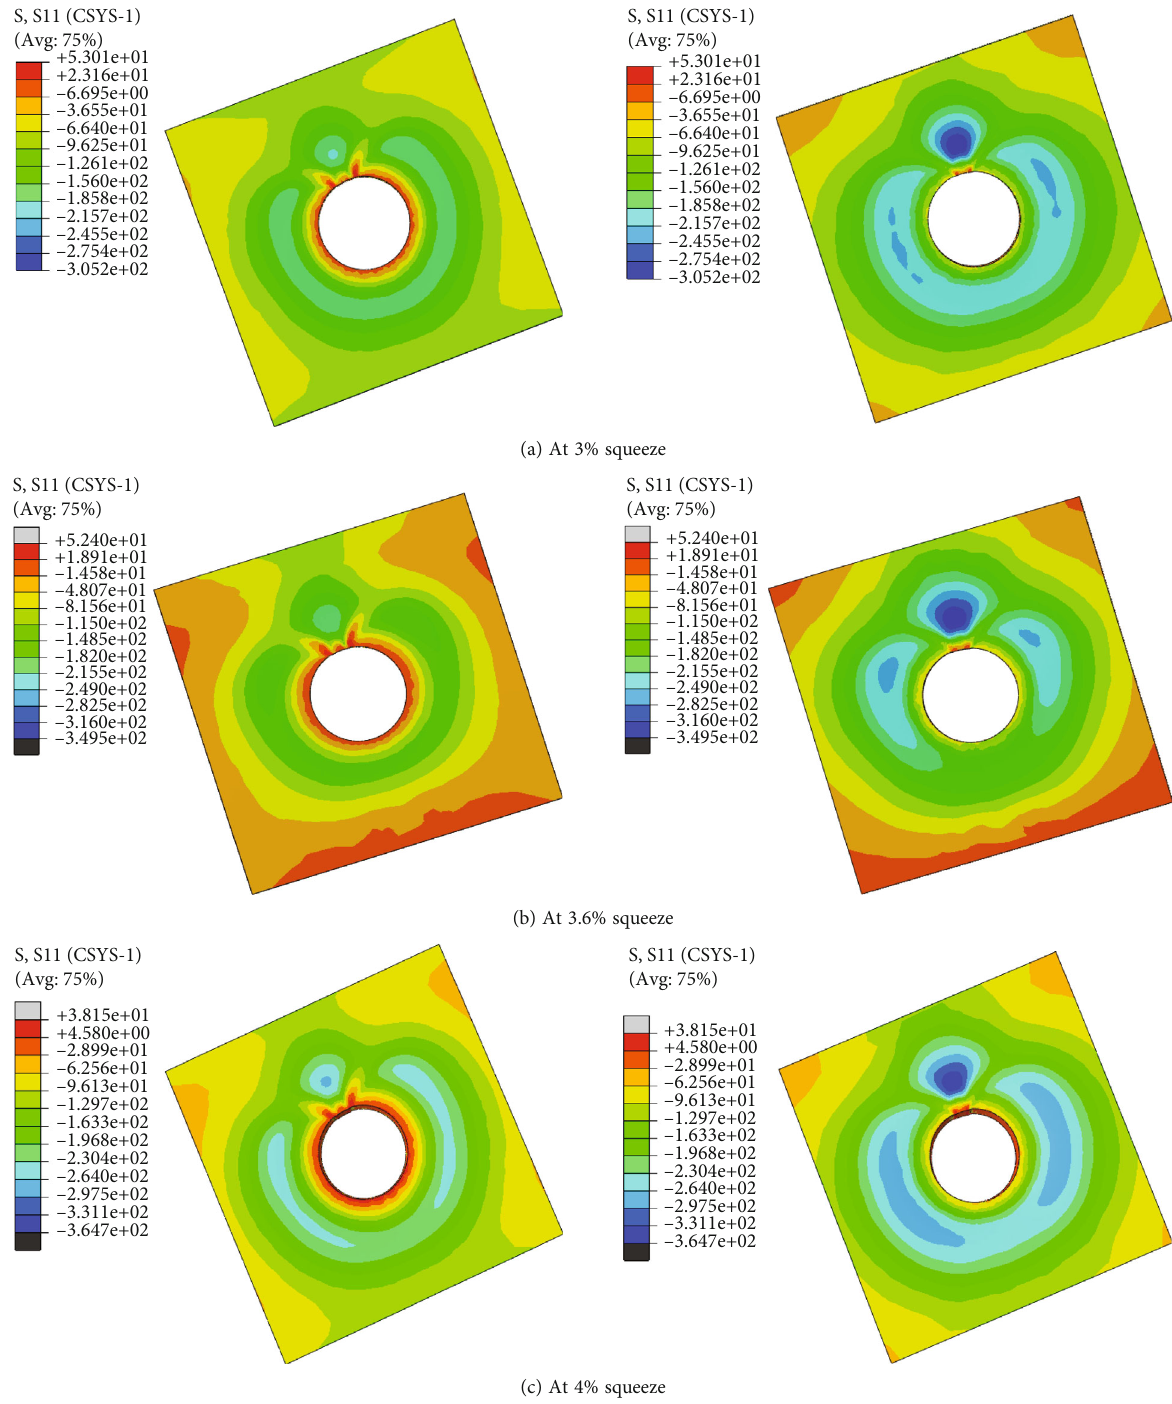
Figure 13: Radial residual stress cloud diagram under di ff erent squeezing amounts (on the left is the extrusion inlet and on the right is the extrusion